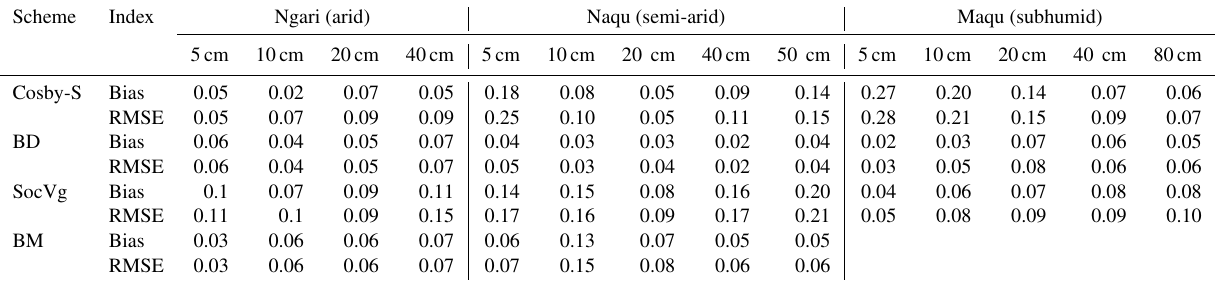
Table A2. Bias and RMSE between simulated porosities with measurements at three climate zones. The unit of listed value is cm 3 cm − 3 .